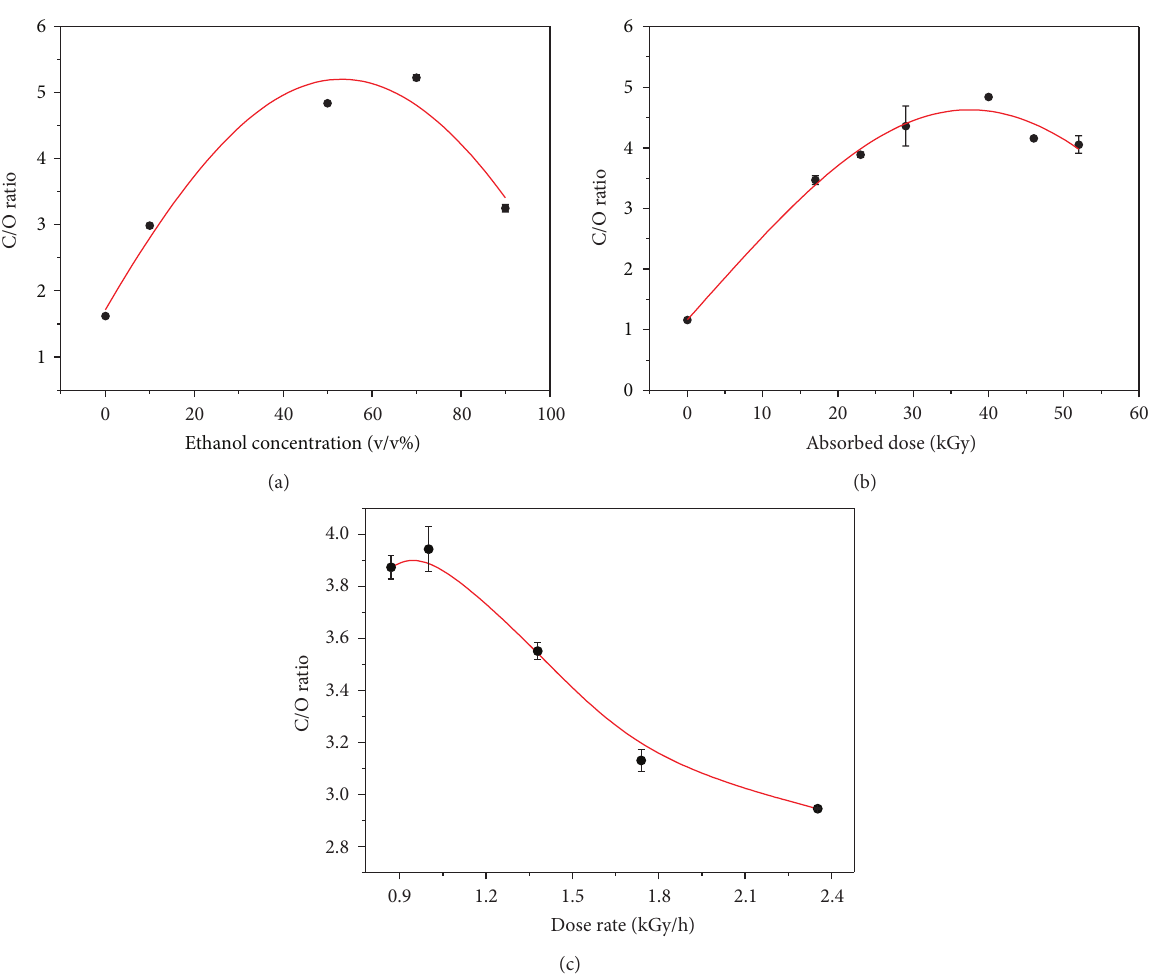
Figure 3: Plots of the C/O ratio of RGO obtained with reaction parameters: (a) ethanol concentration, (b) adsorbed dose, and (c) dose